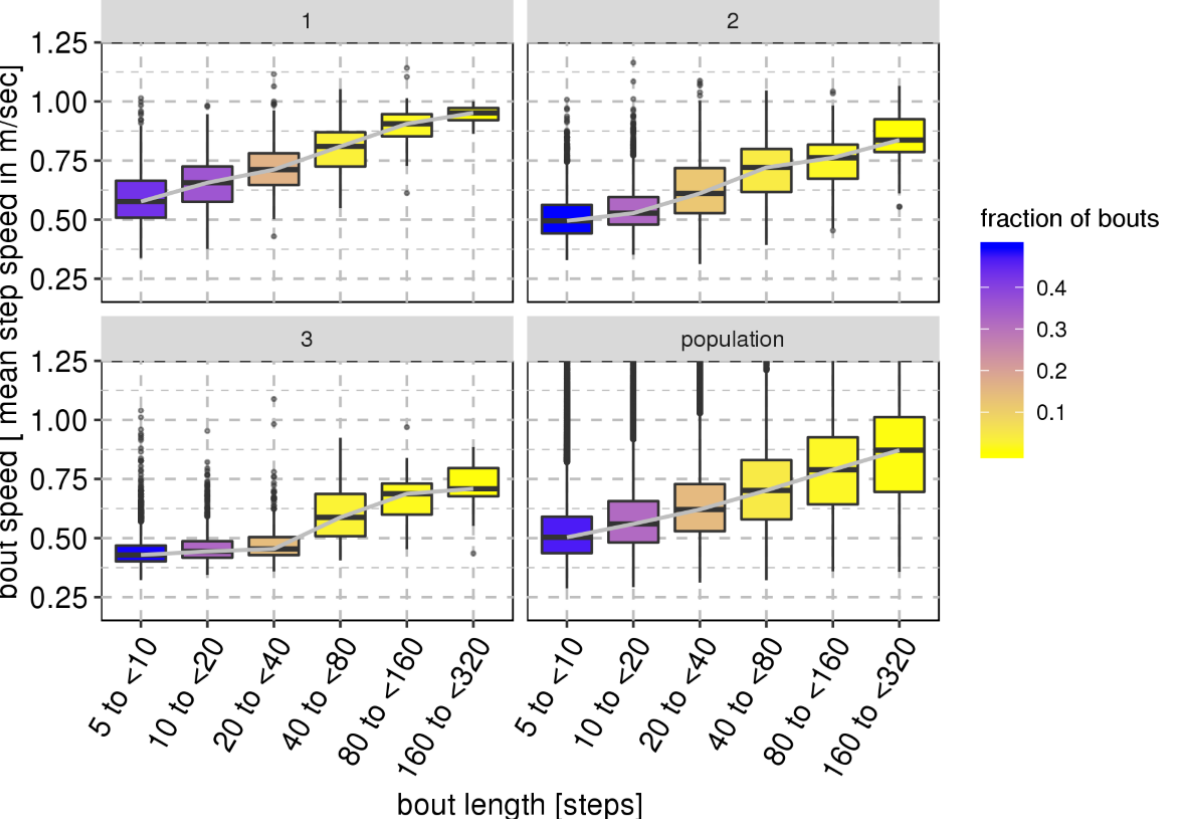
Figure 3. Comparison of gait speed with bout length on a population-level (bottom right panel) and for three representative individual patients (other panels). For all panels, the x-axis shows bout length, divided into groups of increasing numbers of steps, from very short bouts (fewer than 10 steps) to very long bouts (&lt;320 steps), and the y-axis shows the distribution of mean gait speed for each bout. Each boxplot is colored by the fraction of total bouts within that bout length range on a scale between dark blue (boxplots representing a large fraction of bouts) to light yellow (boxplots representing a small fraction of bouts). We observe that gait speed increases with bout length, and the majority of bouts are short in length (i.e. contain few